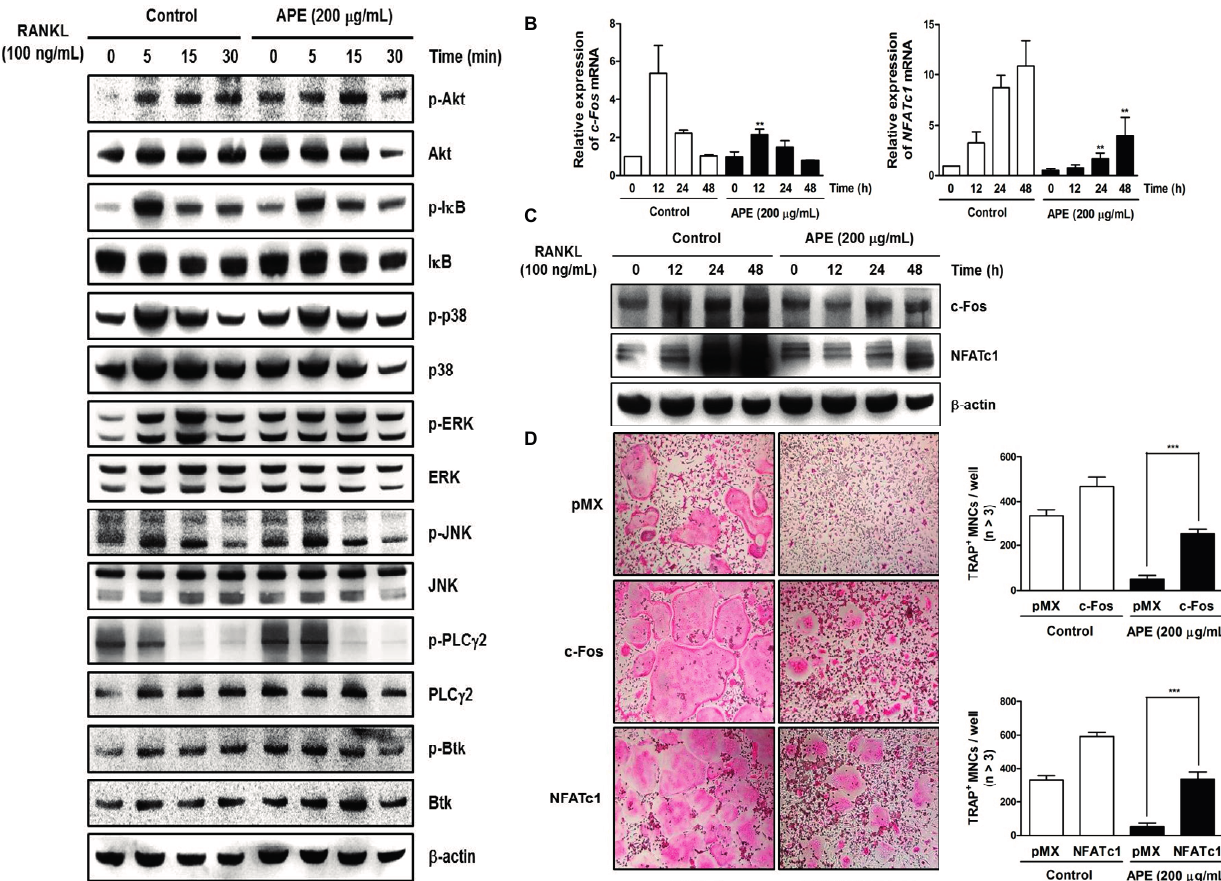
Figure 4. Aconitum pseudo-laeve var. erectum (APE) suppresses receptor activator of nuclear factor kappa-B ligand (RANKL)-induced c-Fos and nuclear factor of activated T-cells, cytoplasmic 1 (NFATc1) expression without stimulating early signal pathways. ( A ) Bone marrow macrophages (BMMs) were pretreated with DMSO (control) or APE (200 µg/mL) for 1 h in the presence of macrophage colony-stimulating factor (M-CSF; 30 ng/mL) and were stimulated with RANKL (100 ng/mL) for the indicated times. Whole-cell lysates underwent western blot analysis with the various indicated antibodies. β -actin served as the internal control; ( B ) BMMs were stimulated with RANKL (100 ng/mL) and M-CSF (30 ng/mL) in the presence or absence of APE (200 µg/mL) for the indicated times. Total RNA was isolated from cells using QIAzol reagent and mRNA expression levels of c-Fos and NFATc1 were evaluated using real-time PCR; ( C ) Effects of APE on protein expression levels of c-Fos and NFATc1 were evaluated using western blot analysis. β -actin was used as the internal control; ( D ) BMMs were infected with retroviruses expressing pMX-IRES-EGFP (pMX), pMX-NFATc1-EGFP, and pMX-cFos-EGFP. Infected BMMs were cultured with or without APE (200 µg/mL) in the presence of M-CSF (30 ng/mL) and RANKL (100 ng/mL) for 4 days. After culturing, the cells were fixed and stained for tartrate-resistant acid phosphatase (TRAP) (left). The TRAP-positive multinucleated osteoclasts were counted (right).